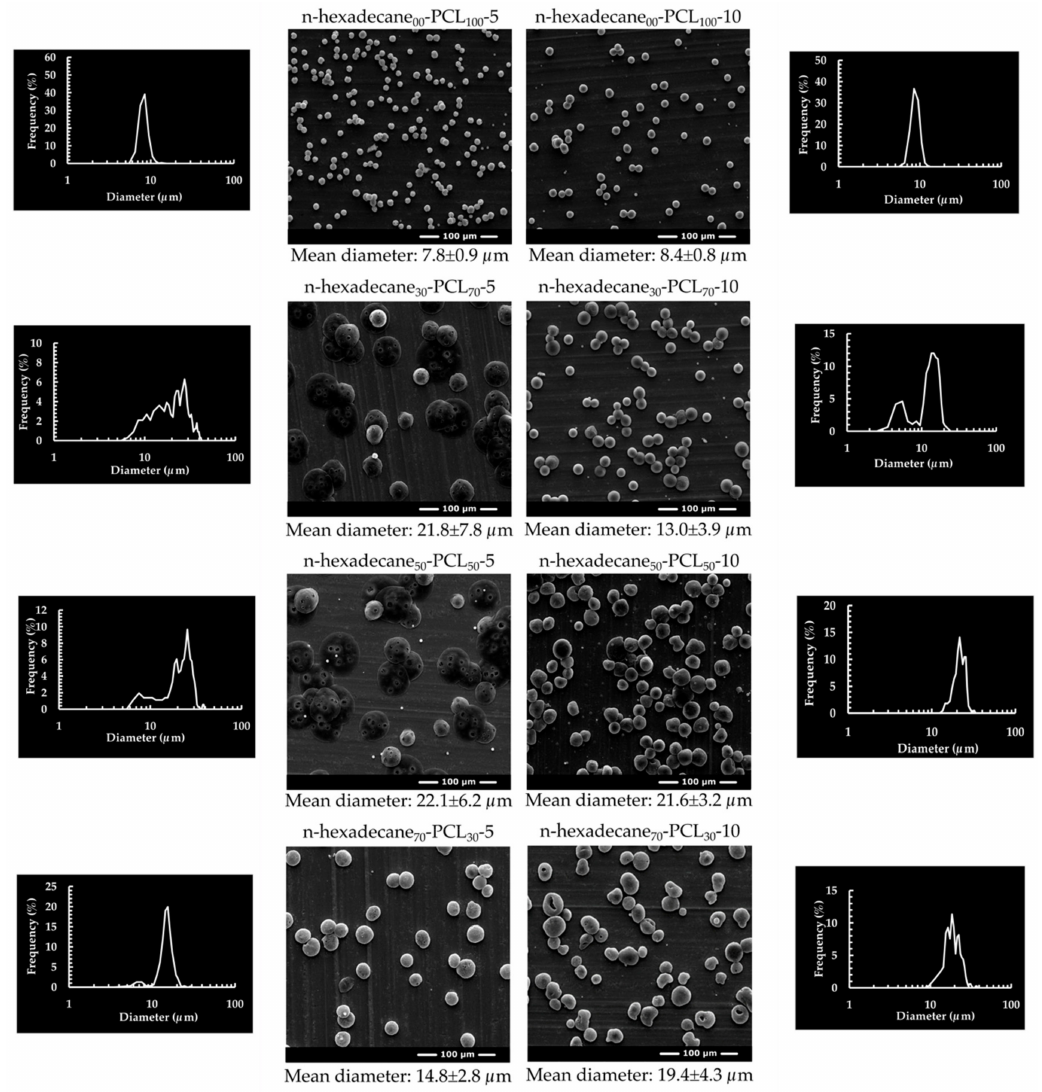
Figure 1. Scanning electron microscopy (SEM) images of the various microparticles and their particle size